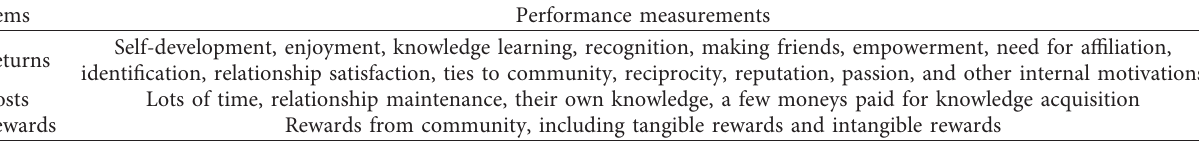
Figure 1: Framework of this paper. Table 2: Measurement of returns and costs.